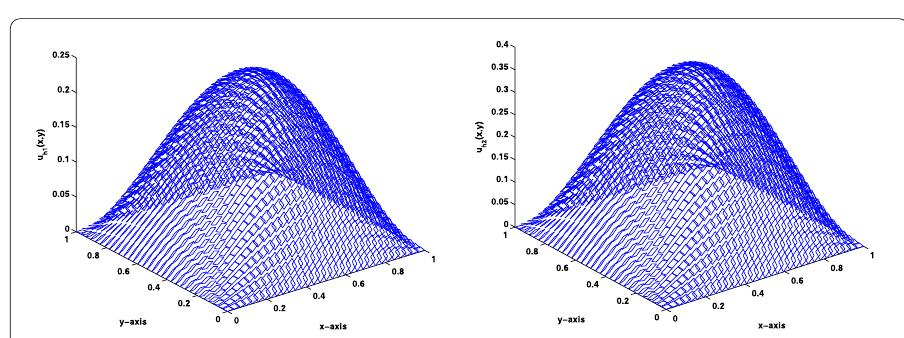
Figure 2 The FEM solutions u h 1 (Real part) and u h 2 (Imaginary part) at t =